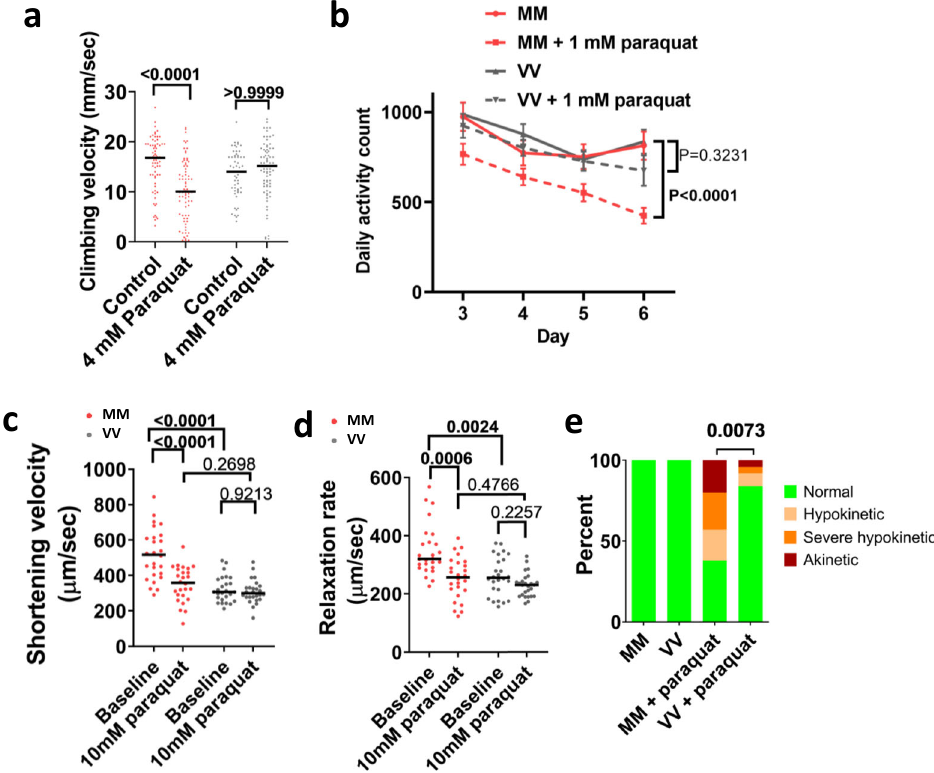
Fig. 6 The MM module sensitizes fl ies to pathological oxidative stress. a Vertical climbing velocity of fl ies treated by control food or food containing 4 mM paraquat for 24 h at 25 °C; n = 68 control-treated MM, n = 74 paraquat-treated MM, n = 57 control-treated VV, n = 75 paraquat-treated VV fl ies. Horizontal lines indicate medians. P values from two-tailed Dunn ’ s multiple comparisons tests shown in the graph. b Daily activity counts of MM and VV fl ies consuming a control or paraquat (1 mM) diet. Diets started at day 1 and behavior monitoring occurred between days 3 and 6 (points and error bars are mean ± SEM. P values calculated using two-tailed Tukey ’ s multiple comparisons test for the effect of paraquat within the genotypes, n = 29 control MM, n = 21 paraquat-treated MM, n = 31 control VV, and n = 21 paraquat-treated VV fl ies). c , d Cardiac performance of hearts bathed fi rst in control arti fi cial hemolymph and then in hemolymph containing 10 mM of paraquat for 90 min; n = 26 hearts per genotype; horizontal lines indicate medians; P value from two-tailed Dunnett ’ s T3 multiple comparisons tests for c and two-tailed Dunn ’ s multiple comparisons tests for d ; choice of tests was determined by data normality. e All MM and VV hearts showed normal contraction before paraquat treatment, however, after exposure to 10 mM paraquat for 150 min, signi fi cantly more MM hearts became hypokinetic, severely hypokinetic, or akinetic (examples of categorical cardiac performance are in Supplementary